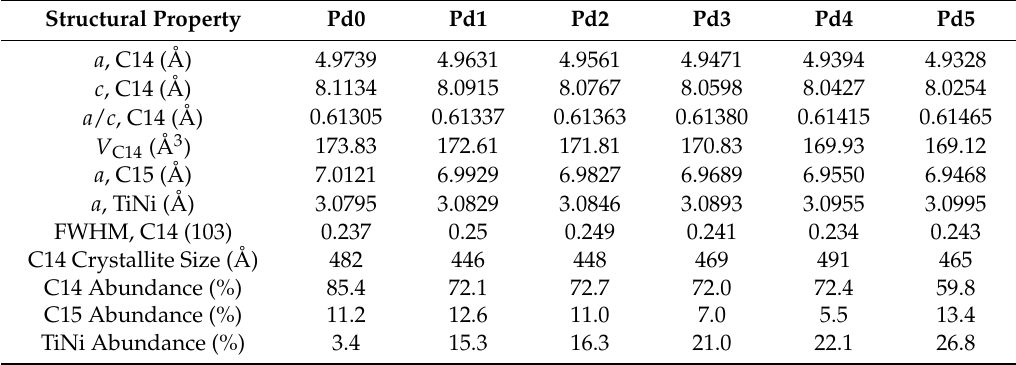
Table 4. Lattice constants a and c , a / c ratio, and unit cell volume ( V C14 ) for the C14 phase, lattice constant a for the C15 and TiNi phases, Full width at half maximum (FWHM), and phase abundances in wt. % calculated from the XRD